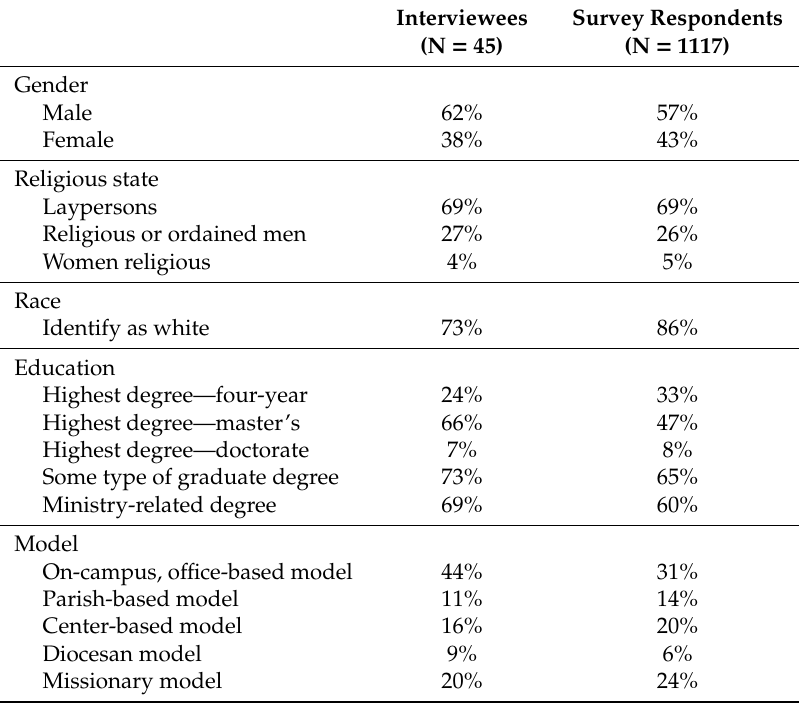
Table 1. Demographics of interviewees and survey